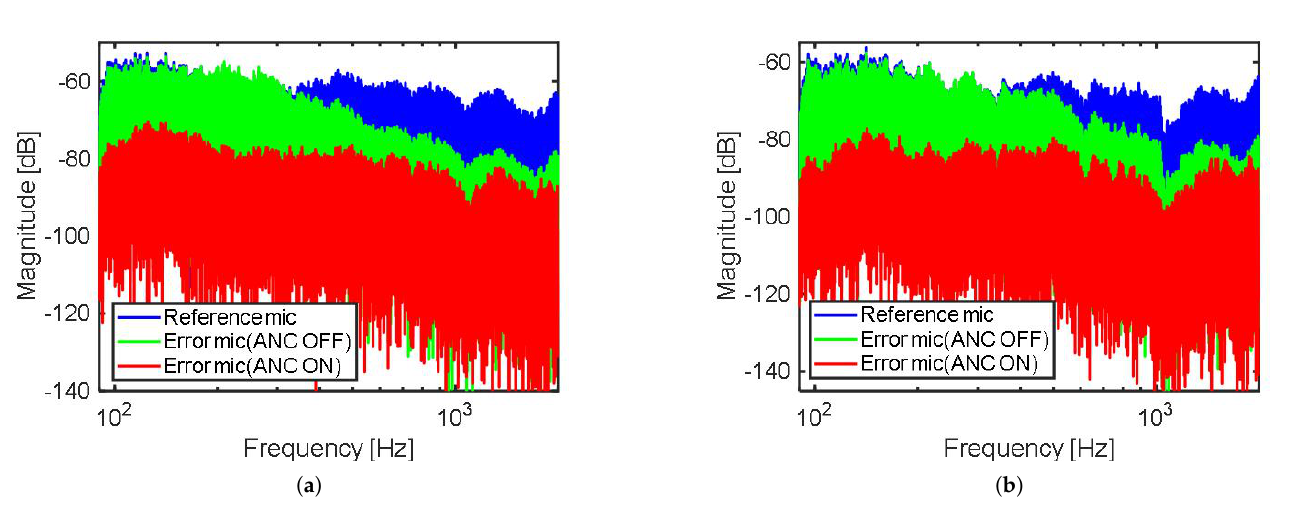
Figure 14. Frequency spectrum of the error microphone output in the in-ear headphone for the ANC of this work. Blue: reference mic, green: error mic (ANC OFF), red: error mic (ANC ON). ( a ) Noise incident from 0 ◦ direction, ( b ) noise incident from 90 ◦ direction.